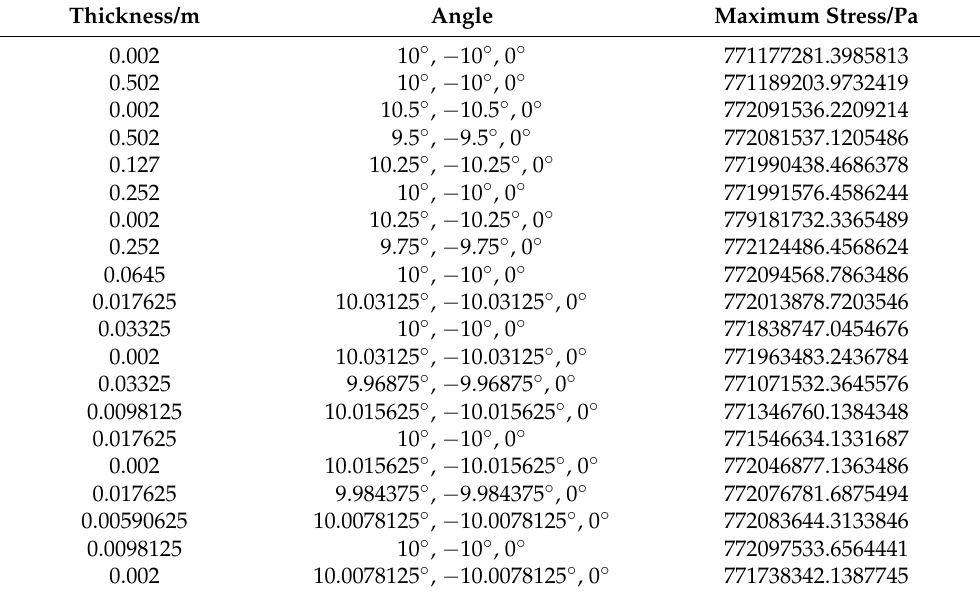
Table 6 lists the results of 20 iterations after function optimization. Table 6. The results of 20 iterations after function optimization